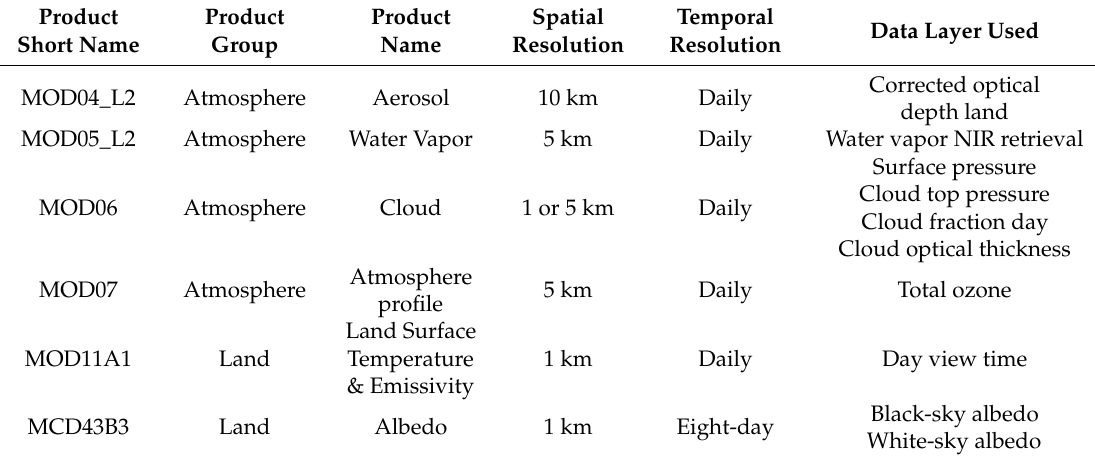
Table 1. MODIS data products level 2 used for the estimation of solar radiative fluxes.